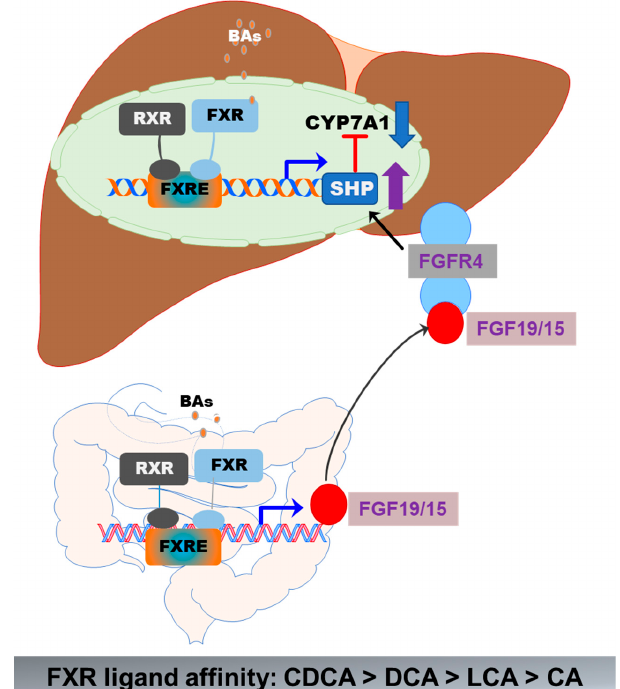
Figure 5. Activation of FXR in the gut–liver axis. In the liver, BA-induced activation of FXR sup- presses CYP7A1 via upregulation of SHP. In the intestine epithelial cells, activation of FXR induces the release of FGF19/15, which activates FGFR4 in hepatocytes, resulting in the upregulation of SHP and downregulation of CYP7A1 expression. The formation of the FXR and RXR heterodimer further enhances the activity of FXR.